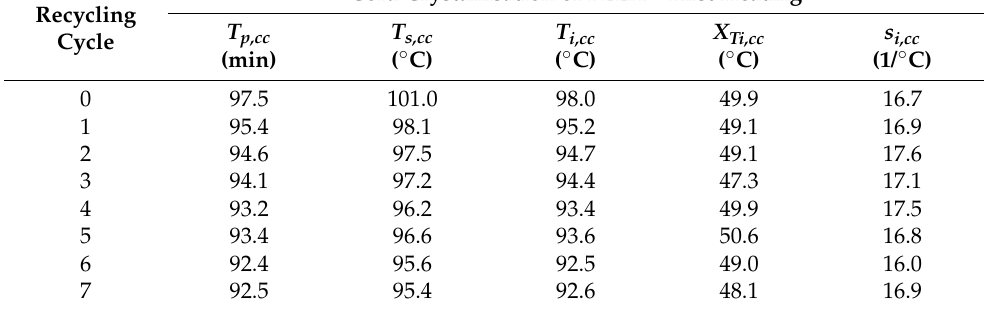
Table 5. Cold crystallisation temperature ( T p,cc ), cold crystallisation starting temperature ( T s,cc ),